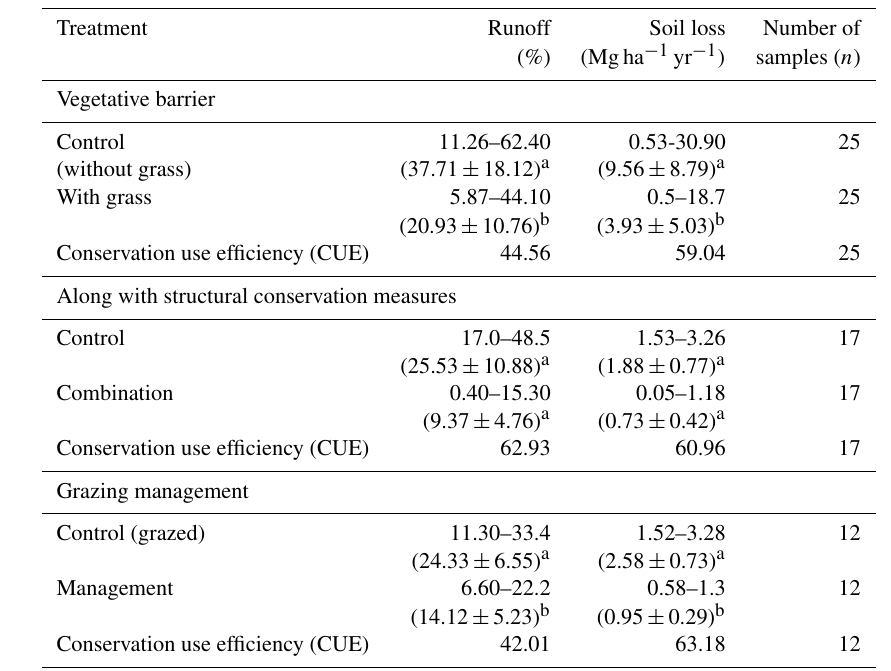
Table 3. Impact of grasses in arresting soil loss and runoff.